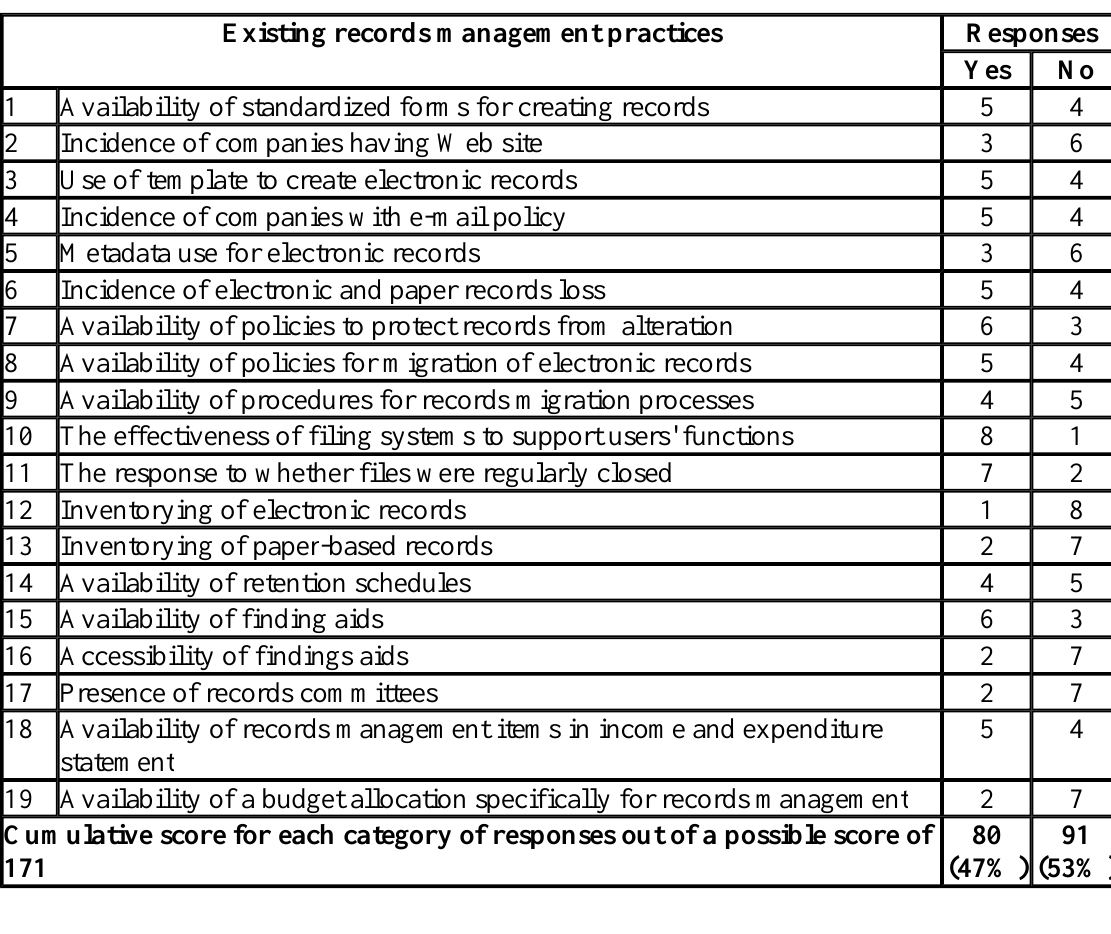
Table 1 Records management practices in selected companies in the Iringa